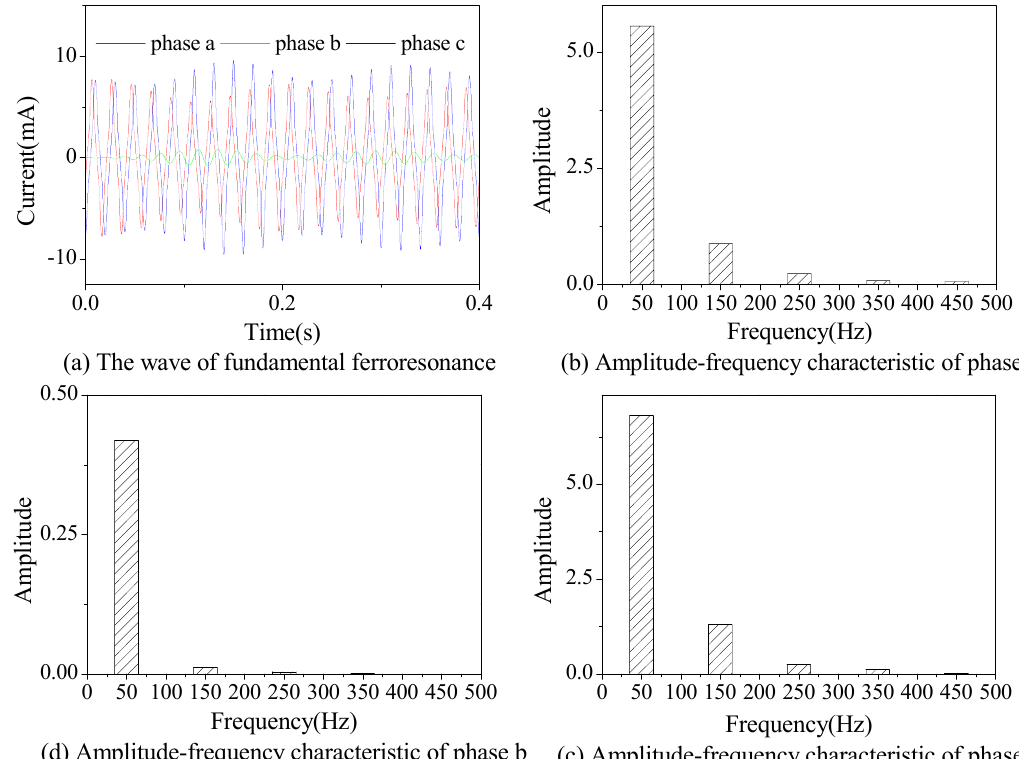
Figure 2. Simulated fundamental ferroresonance over-current signals and the Fourier transform result.